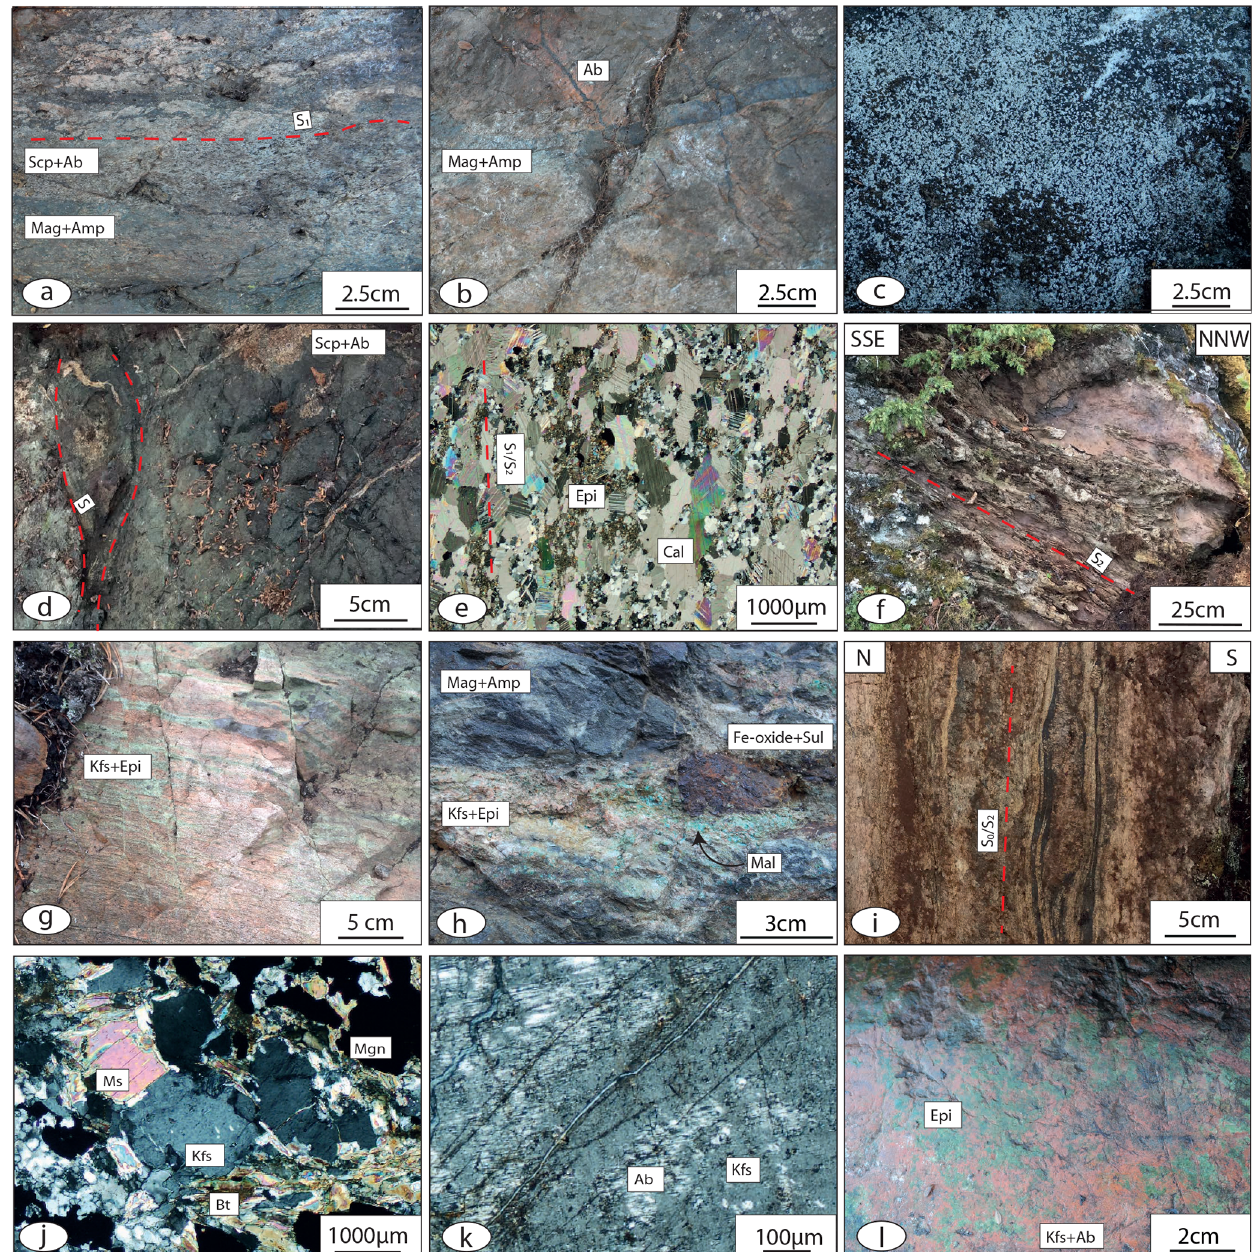
Figure 17. Thin-section and field images of alteration styles throughout the WSB. (a) Scapolite + albite overprinting magnetite + amphibole, X695488 Y7507194, Kaitum West. (b) Vein-hosted magnetite + amphibole with reddish albite haloes, X695459 Y7507412, Kaitum West. (c) Scapolite porphyroblasts, X696049 Y7507684, Kaitum West. (d) Scapolite in veins and patches transposed by later shear bands, X697177 Y7532766, Vieto (see Fig. 2). (e) Calcite overprinting actinolite–tremolite in L tectonite in Fig. 9a. Calcite aligned with S 1 /S 2 with unde- formed granular epidote at grain boundaries, X689886 Y7530423, Ekströmsberg. (f) Reddish calcite overprinting ductile shear zone fabrics, X698369 Y7534383, Vieto (see Fig. 2). (g) K-feldspar + epidote concentrated along volcanosedimentary bedding X721289 Y7471362, Fjällåsen–Allavaara. (h) K-feldspar + epidote + Fe-oxide + sulfide + malachite overprinting pervasive magnetite + amphibole, X694578 Y7506821, Kaitum West. (i) E–W-directed D 2 shear zone with magnetite bands, X690231 Y7527374, Ekströmsberg. (j) Shear-band-hosted biotite + magnetite + quartz + K-feldspar + muscovite from the locality in (l) , Ekströmsberg. (k) Selectively pervasive K-feldspar replacing albite in same outcrop as Fig. 9c, X691491 Y7527635, Ekströmsberg. (l) Selectively pervasive K-feldspar alteration overprinted by epi- dote on a fracture plane, X696619 Y7508353, Kaitum West. Coordinates in Sweref99. Scp: scapolite; Ab: albite; Mag: magnetite;